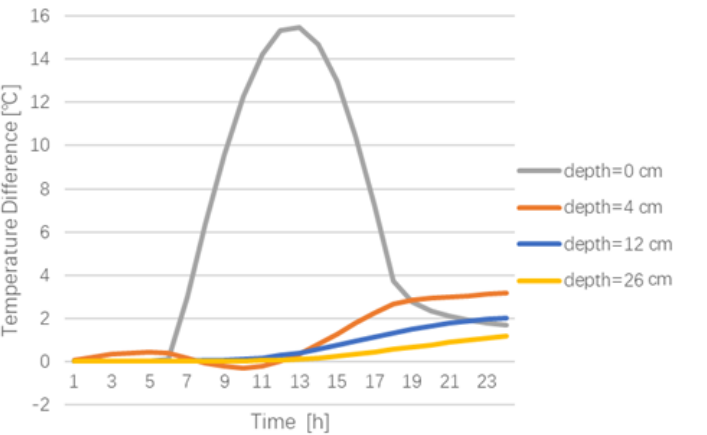
Figure 10. Temperature difference between the conventional pavement and cool pavement at different moments.